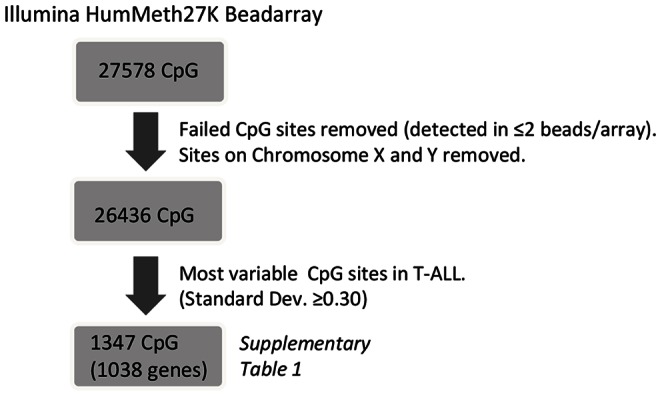
Schematic overview of the methylation array analysis.